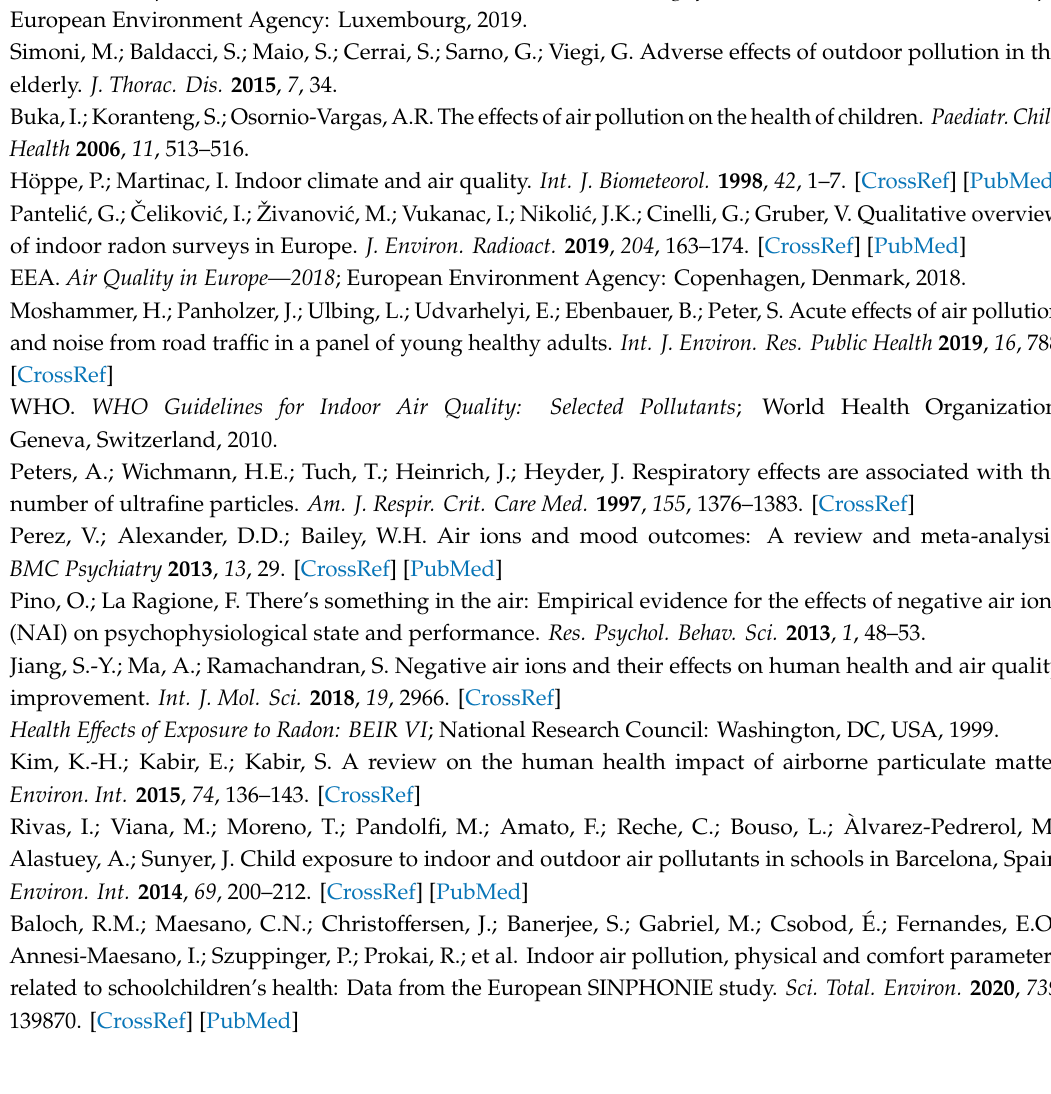
Figure A2. ( a ) ANN considered in this paper. Optimal model has two PCA components and 4 ReLU neurons. ( b ) Plot of a ReLU activation function.